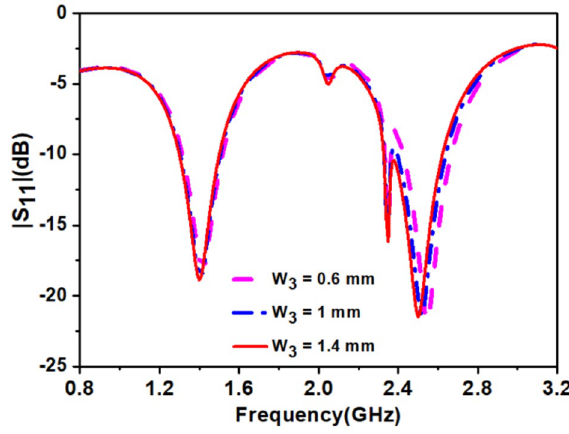
Figure 6. Effect of width ( w 3 ) of stub-1 on |S 11 |.